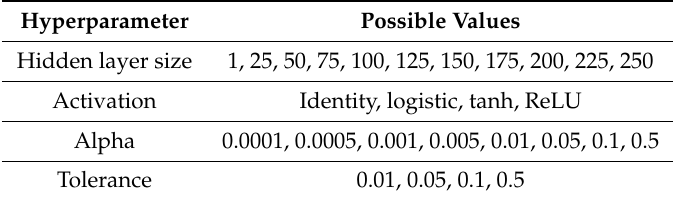
Table 4. Possible values for the remaining hyperparameters.